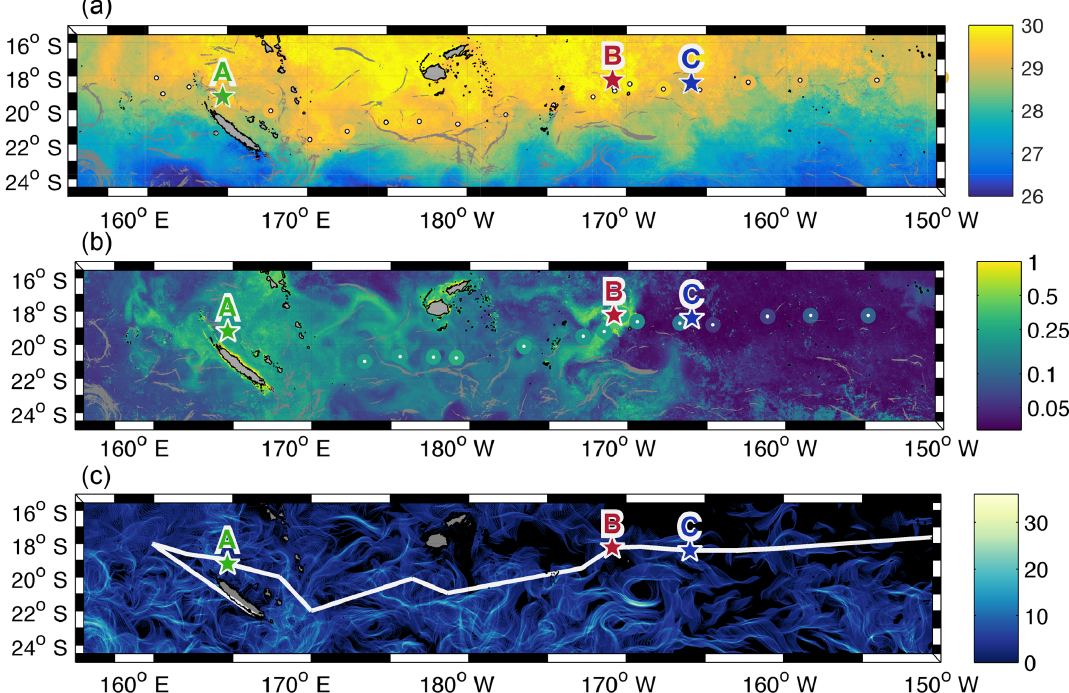
Figure 6. (a) Lagrangian satellite sea surface temperature ( ◦ C) (for the time period of the OUTPACE cruise, adapted from de Verneil et al., 2017) from CLS superimposed with 5-day weighted mean of sea surface temperature ( ◦ C) from TSG (coloured circles with centres indicated in white). (b) Lagrangian satellite-derived surface chlorophyll concentration (mgm − 3 ) (for the time period of the OUTPACE cruise, adapted from de Verneil et al., 2017) from CLS superimposed with 5-day weighted mean of surface chlorophyll concentration (mgm − 3 ) measured onboard during OUTPACE (coloured circles with centres indicated in white). Fronts are present for at least 10 days during the OUTPACE cruise are indicated in grey in both figures. (c) Recurrence of FSLE structures (number of days of FSLE presence, colour